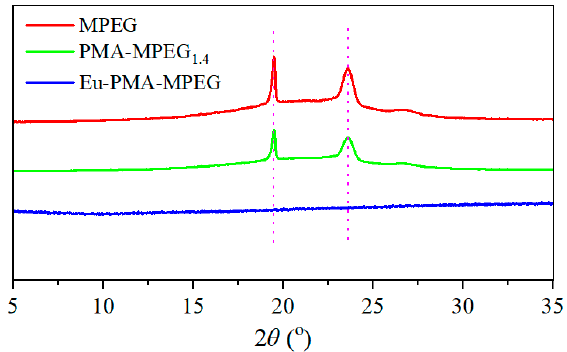
Figure 4. XRD patterns of pure MPEG, PMA-MPEG 1.4 and